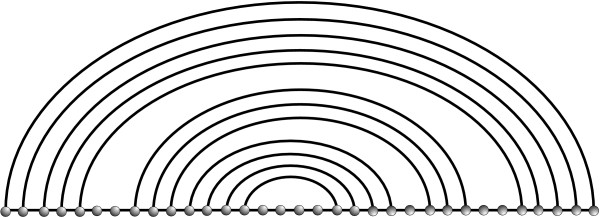
Stems. A stem composed by a sequence of three nested stacks. Note that respective stacks only have to be separated by isolated nucleotides on either the left hand side or the right hand side but not necessarily both.